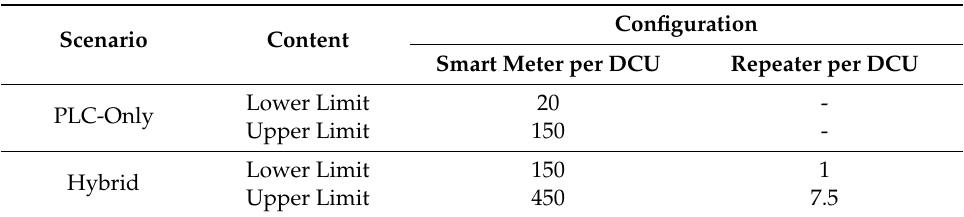
Table 11. Sensitivity Analysis Setup.